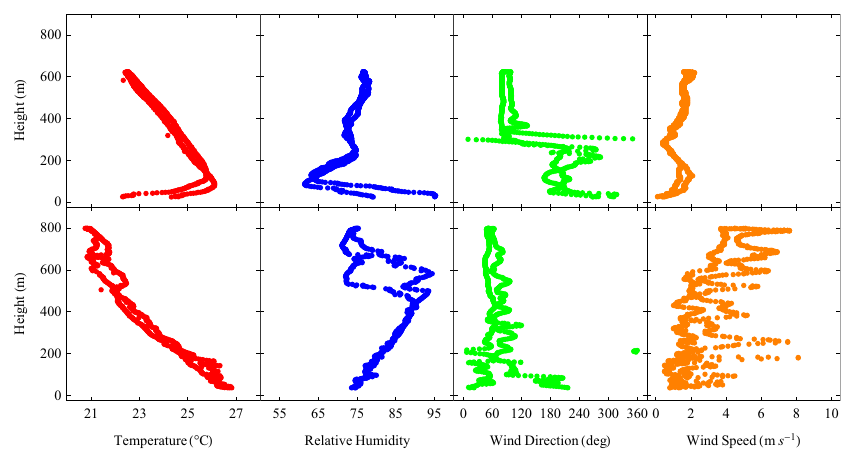
Fig. 9. Vertical profiles of temperature, relative humidity, wind direction, and wind speed from balloon soundings at site K23. Top row: night, 04:18 through 04:52UTC of 14 March 2008. Bottom row: day, 16:29 through 16:59UTC of 15 March 2008. Local time was − 4h with reference to coordinated universal time (UTC), and this region of the Amazon does not practice daylight savings time.